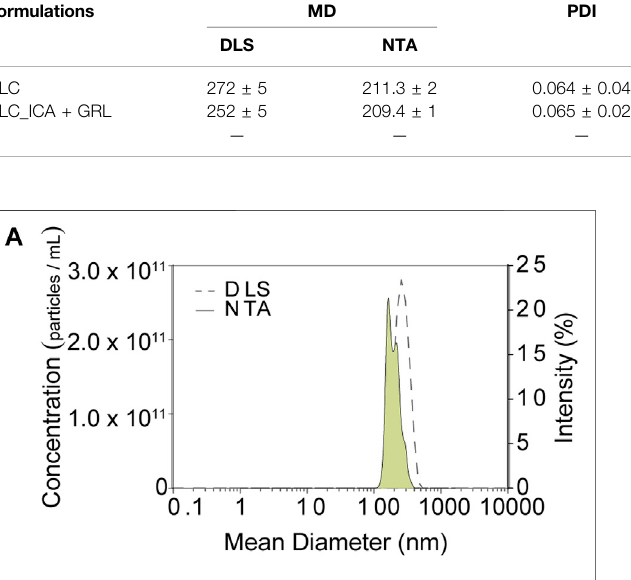
Frontiers in Pharmacology |